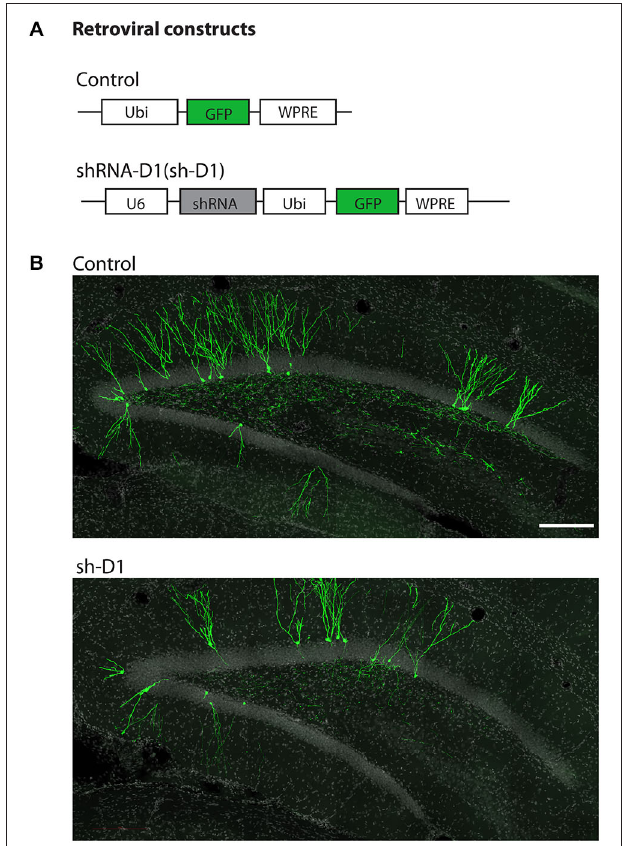
FIGURE 1 | Stereotaxic injection of retrovirus in the dentate gyrus of the adult rat hippocampus. (A) Schematic diagram of the retroviral vector used for in vivo birth-dating and genetic manipulation. (B) Sample projections of Z -series confocal images at 4 wpi of retrovirus either expressing GFP (control) or co-expressing shRNA against Disc1 and GFP (sh-D1) in the dentate gyrus of the adult rat hippocampus. Scale bar: 200 µ m.